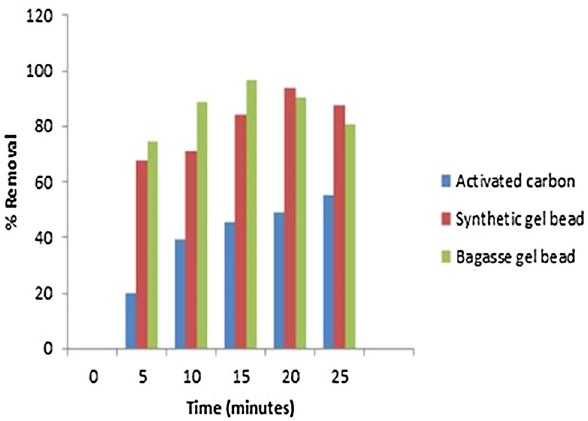
Fig. 3 Effect of time on the adsorption of chromium ions onto bio- polymer beads and activated carbon = 0.2, 0.3 g, pH = 4.6, tempera- ture = 25 °C